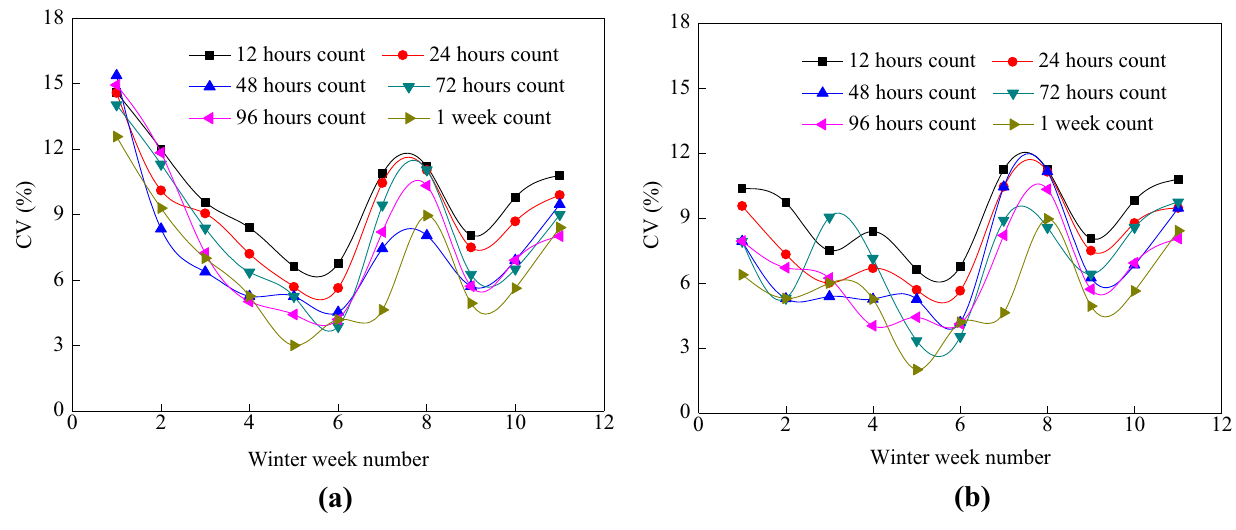
Fig. 1 CV values for all SDCs during winter for a RCOM60200260 and b